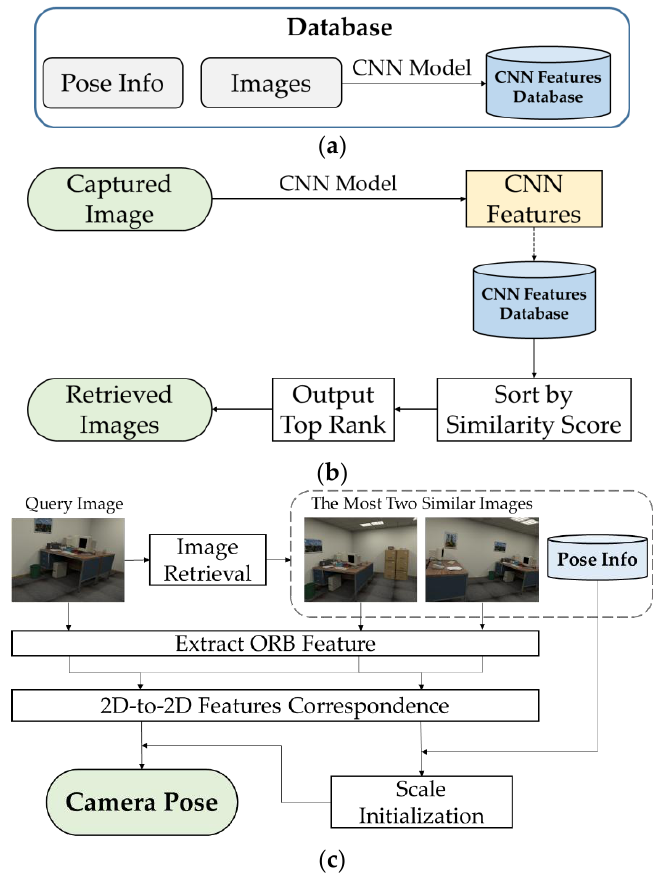
Figure 1. Overview of our visual indoor positioning method. The process is composed of ( a ) database construction; ( b ) image retrieval; and ( c ) pose estimation stages.